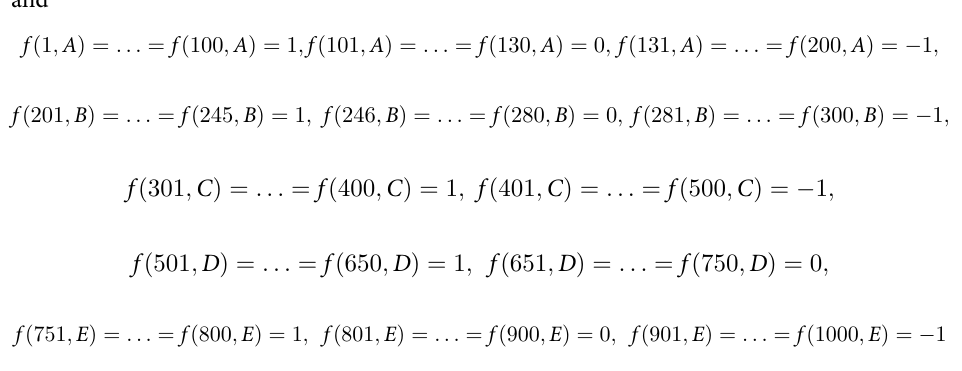
Table 2 below is presented the conflict situation above. Table 2 presents a decision table in which only condition attribute is Party , and the decision attribute is Voting . The table describes voting results in a parliament containing 1000 members